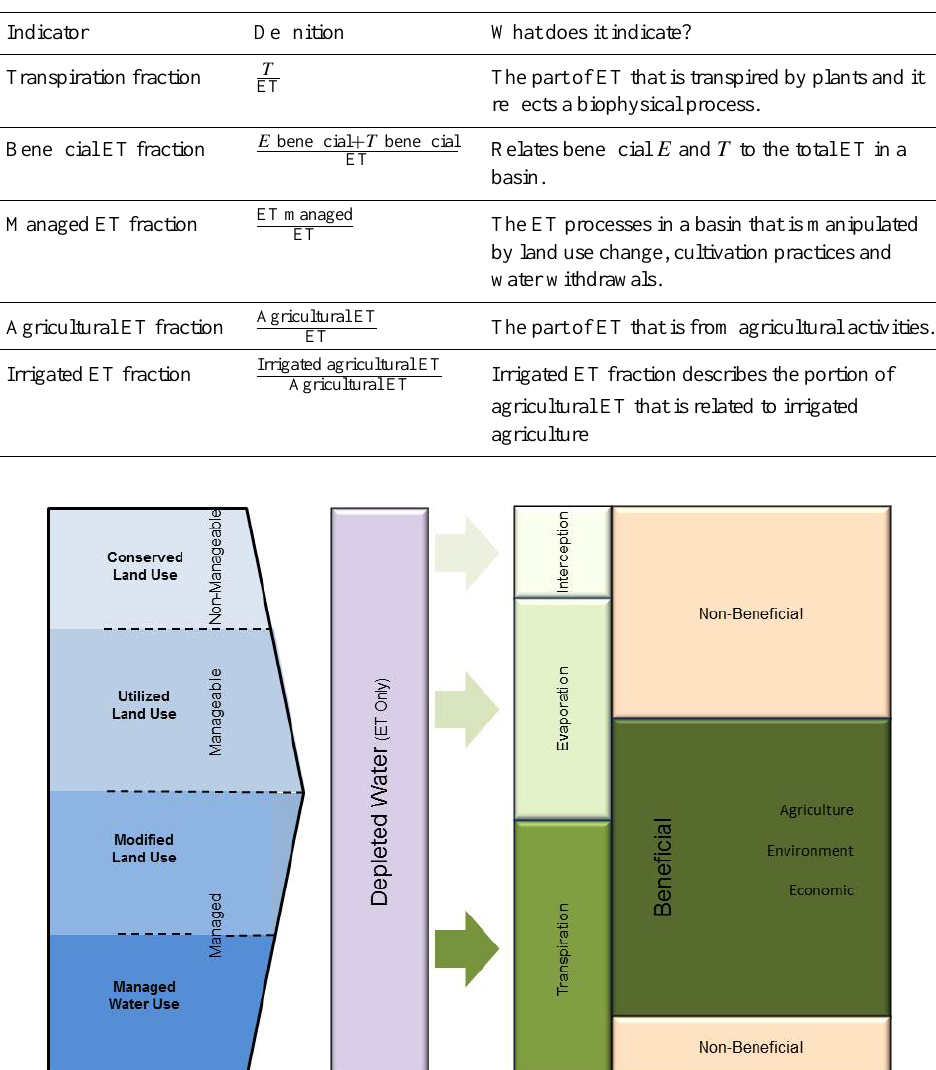
Table 3. Key performance indicators of the evapotranspiration sheet.